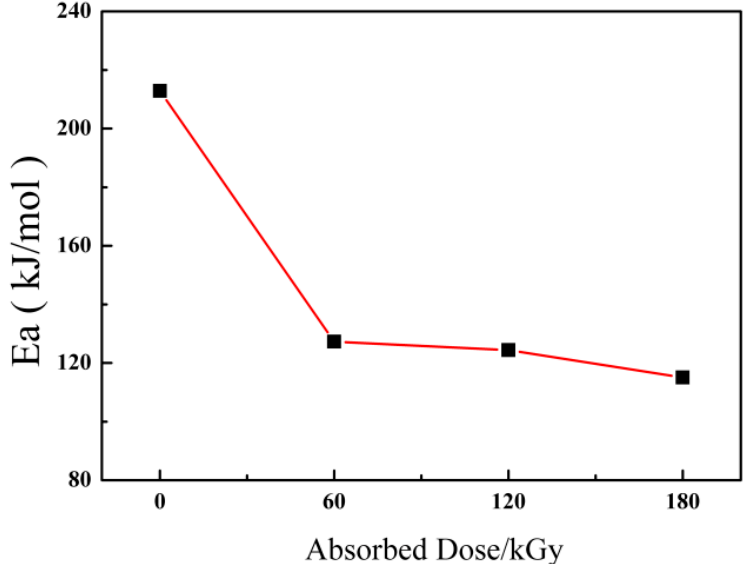
Figure 5. Activation energy of ETFE against absorbed irradiation doses.